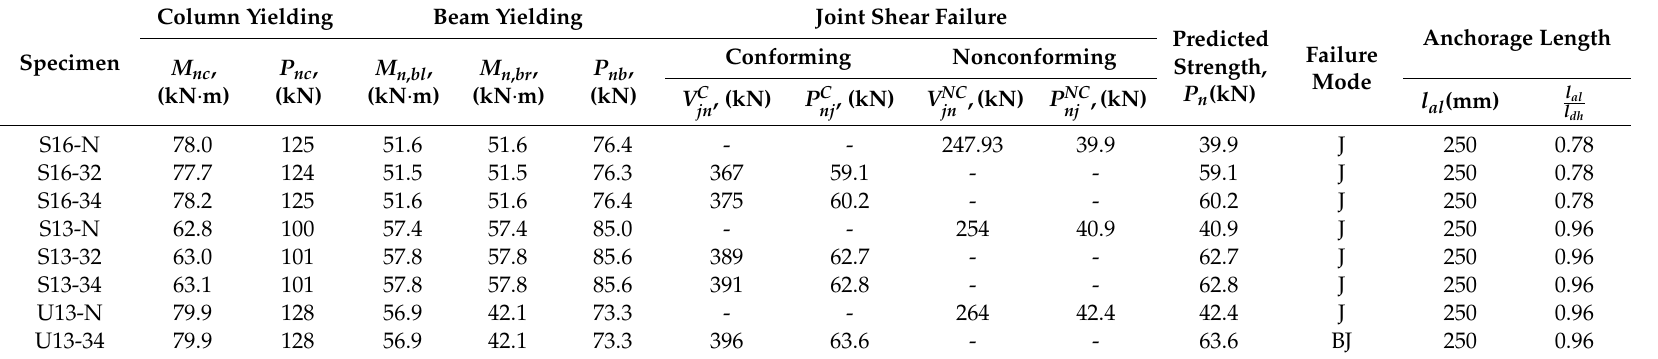
Table A1. Prediction of the Nominal Strengths and Failure Modes